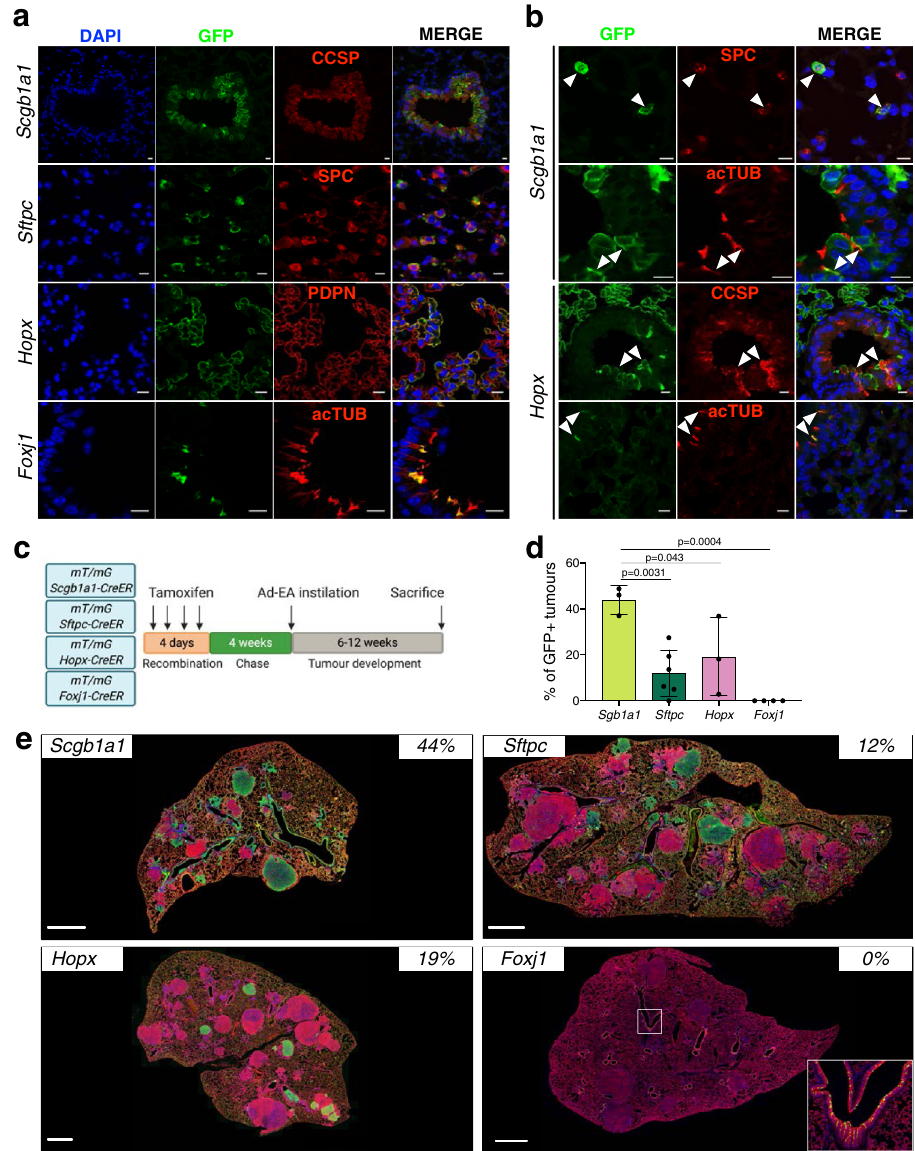
Fig. 2 | Lineage-tracing models. a Immuno fl uorescent staining of GFP and the indicated antibodies in the different lineage-tracing mouse models ( Scgb1a1 , Sftpc , Hopx and Foxj1 ) showing the speci fi c labelling (CCSP, SPC, PDPN and acTUB). Images of single-channel and overlay are displayed sequentially. Scale bars: 10 μ m. A minimum of 6 independent animals were analysed. b Immuno fl uorescent staining of GFP and the indicated antibodies (CCSP, SPC andacTUB)inthelungsectionsfromlineage-tracingmousemodelsshowingthe labelling speci fi city. Arrows indicate the unspeci fi c labelling of the cells. Scale bars:10 μ m.Aminimumof6independentanimalswereanalysed. c